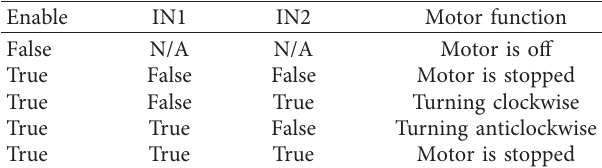
Table 5: Mapping intent to robot